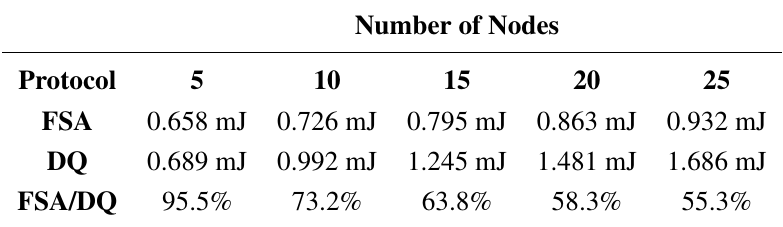
Table 5. Energy consumption of Frame Slotted ALOHA (FSA) and Distributed Queuing (DQ). The FSA/DQ quotient represents the energy savings of using FSA with respect to DQ. In this case, using the optimal FSA leads to a reduction in energy consumption between 5% to 45% compared to